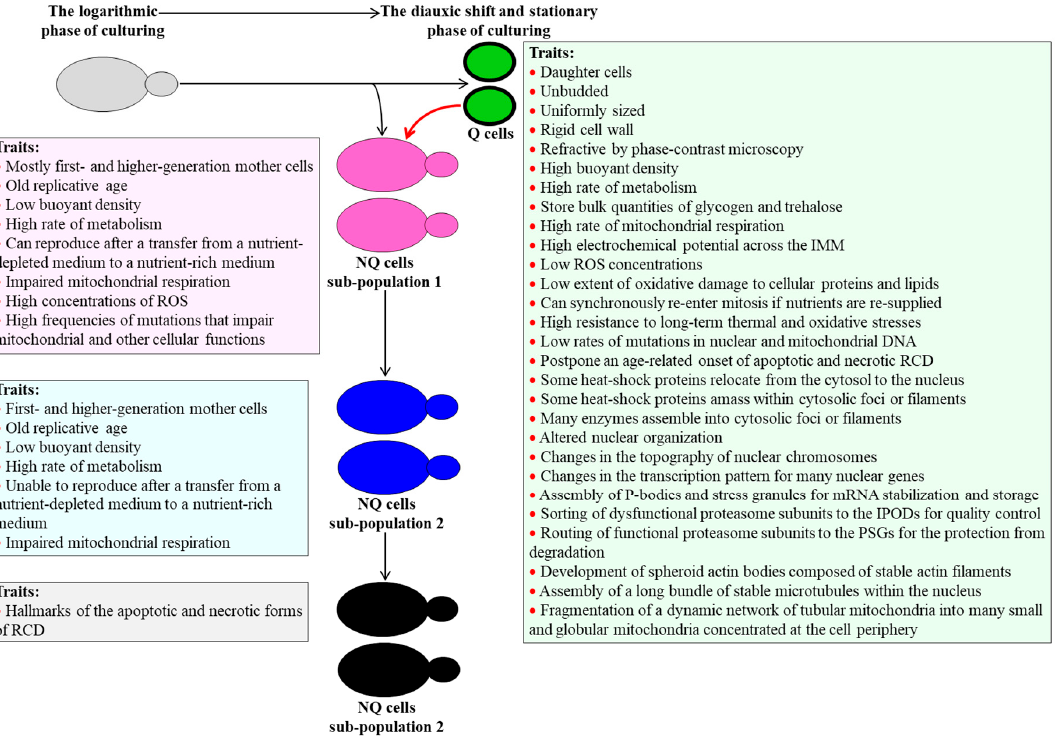
Figure 1. At the time of the diauxic shift, a Saccharomyces cerevisiae culture under non-caloric restriction (CR) conditions begins to accumulate a sub-population of quiescent (Q) cells and a sub-population 1 of non-quiescent (NQ) cells. NQ cells of the sub-population 1 undergo a stepwise conversion into NQ cells of the sub-population 3. The Q and NQ cell sub-populations differ from each other in many distinct traits. In chronologically aging S. cerevisiae cultures, Q cells undergo conversion into NQ cells of the sub-population 1 in an age-related manner. See the text for more details. Abbreviations: IMM, the inner mitochondrial membrane; IPODs, insoluble protein deposits; PSGs, proteasome storage granules; RCD, regulated cell death; ROS, reactive oxygen species.